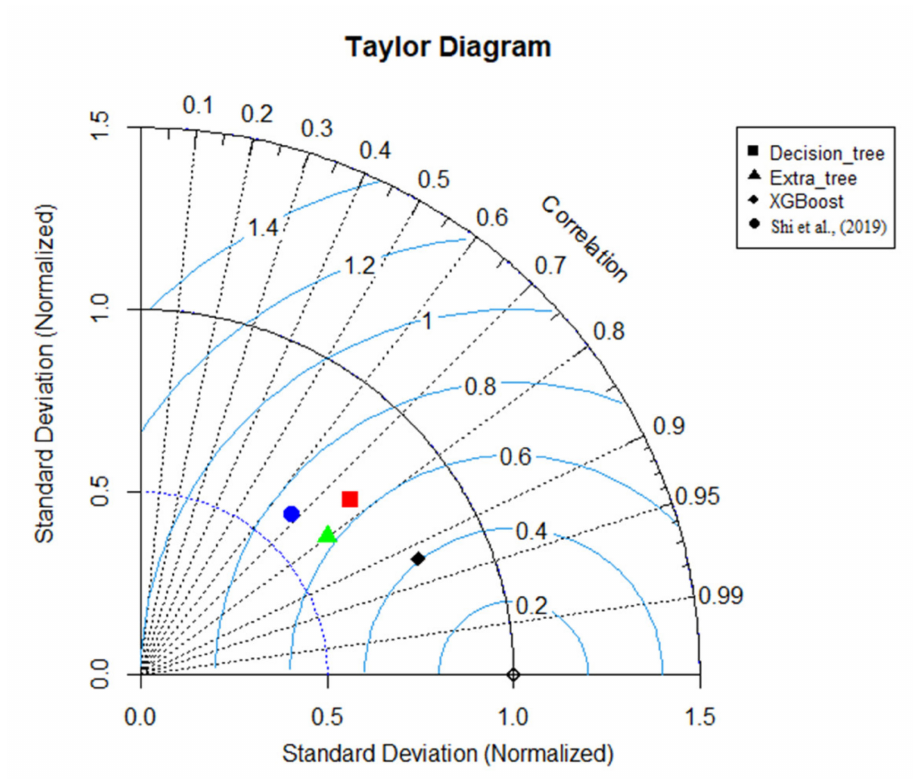
Figure 8. Taylor diagram for f S predictions; Shi et al